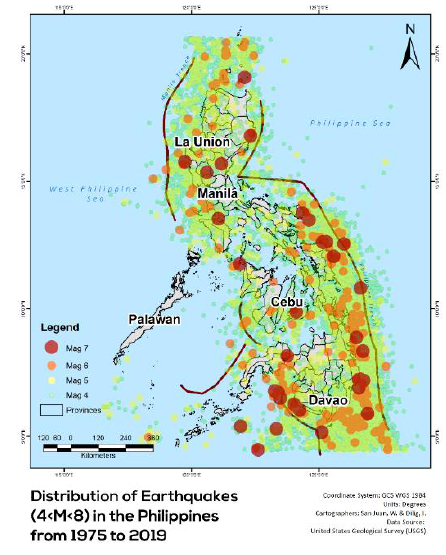
Figure 4. Distribution of Earthquakes in the Philippines from 1975 to 2019